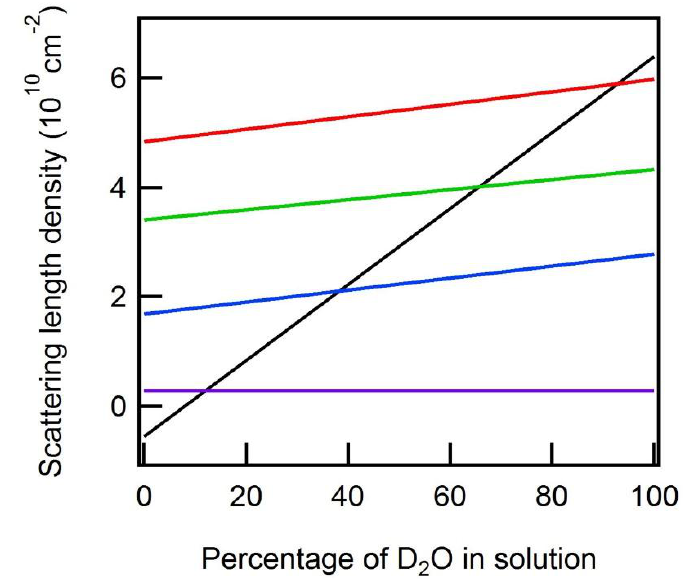
Figure 2. Scattering length densities of various biological macromolecules plotted as a function of percent D 2 O in the solvent: a hydrogenated protein (blue), a deuterated protein with 65% of the non-exchangeable protons replaced by deuterium (red), messenger ribonucleic acid (mRNA) (green), and lipid (purple). The black line corresponds to the scattering length density of the background solution. The “match” point of these macromolecules (circled) is found at the percent D 2 O where the scattering light density (SLD) of the solvent equals that of the molecule.